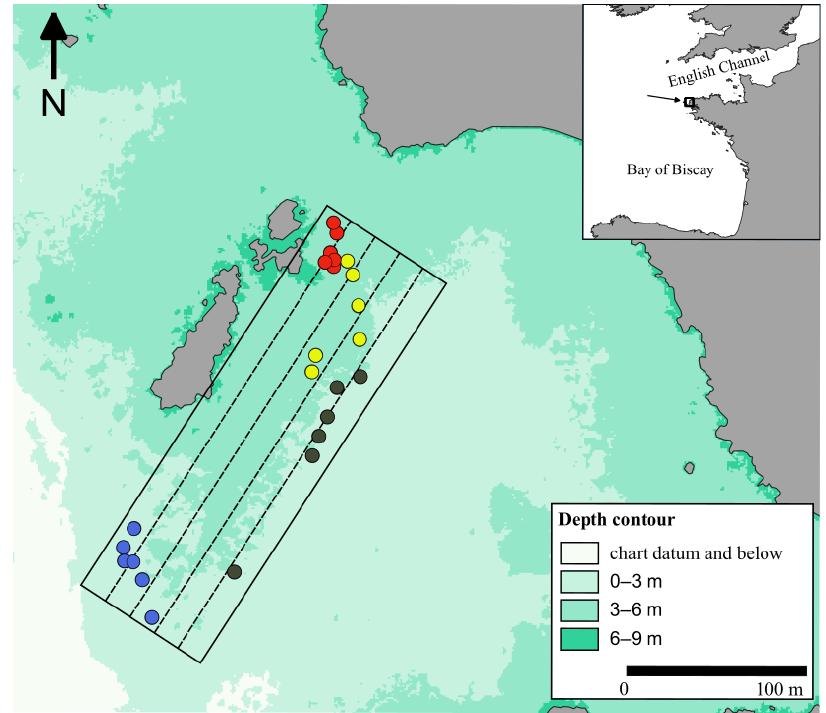
Figure 1. Study site of Porspoder (Brittany, France: 48 ◦ 28.88 (cid:48) N/4 ◦ 46.29 (cid:48) W) showing the 24 in situ sampling spots surveyed during the study. The color of the circles indicates the intertidal level considered: red circles, P. canaliculata — F. spiralis ; yellow circles, A. nodosum ; black circles, F. serratus ; blue circles, H. elongata . The dotted lines correspond to the UAV flight